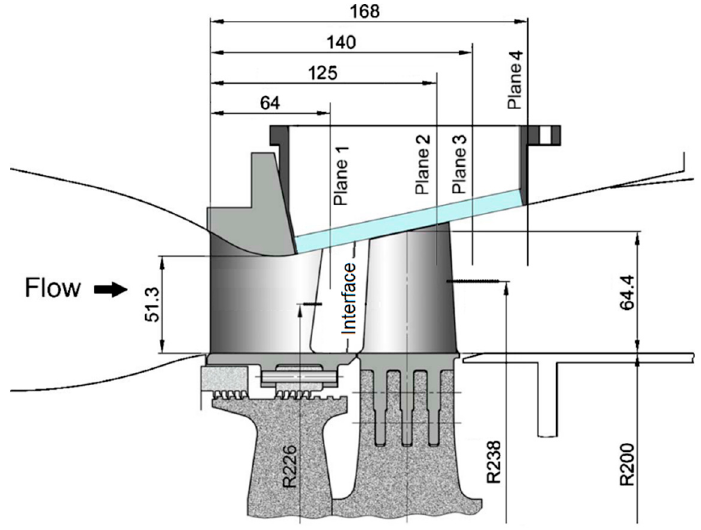
Figure 1. Meridional flow path of the transonic turbine stage (Reproduced from [17]).